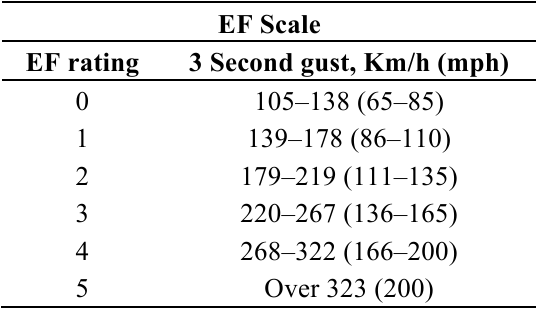
Table 2. Enhanced Fujita (EF) scale for tornado